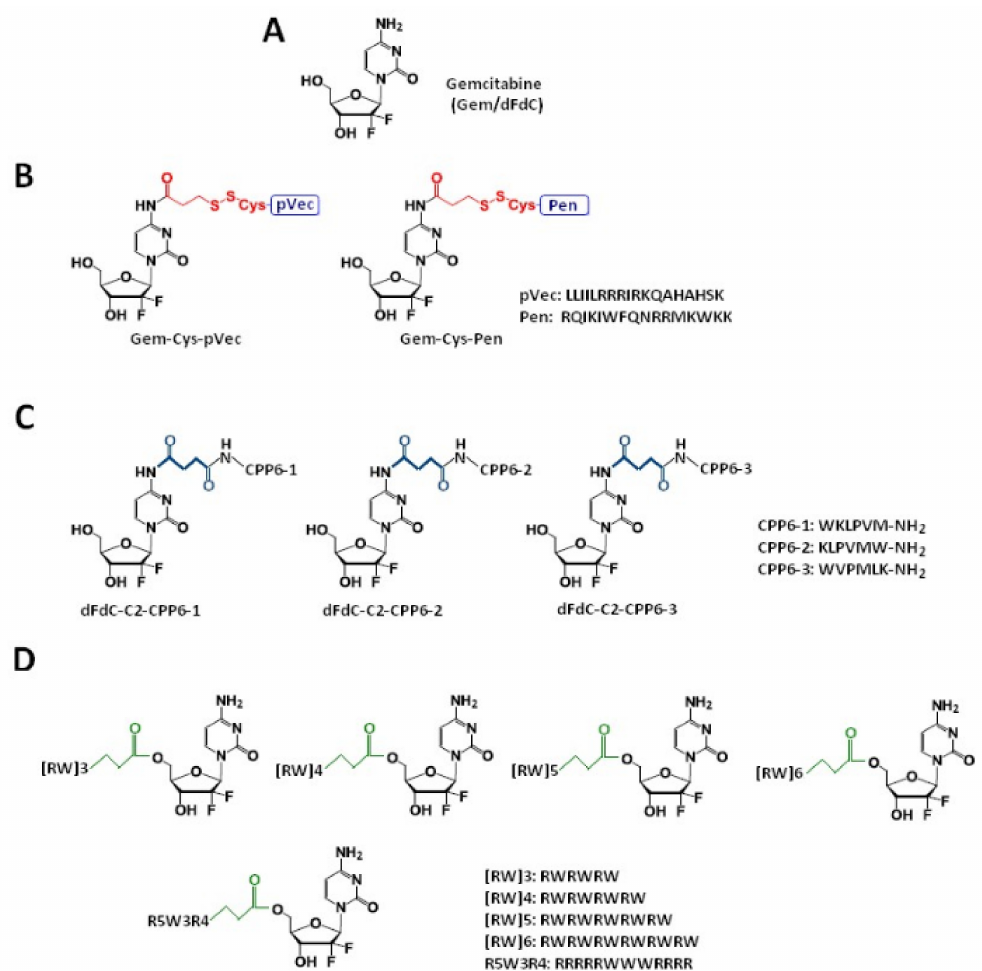
Figure 2. Chemical structures of gemcitabine ( A ) and their conjugates with CPPs and their constituents. ( B ) Gem-Cys-Pen and Gem-Cys-pVec conjugates: Conjugates of gemcitabine with Penetratin and pVec; ( C ) CPP6–dFdC: Conjugates of gemcitabine with CPP6; and ( D ) conjugates of gemcitabine with arginine and tryptophan-rich